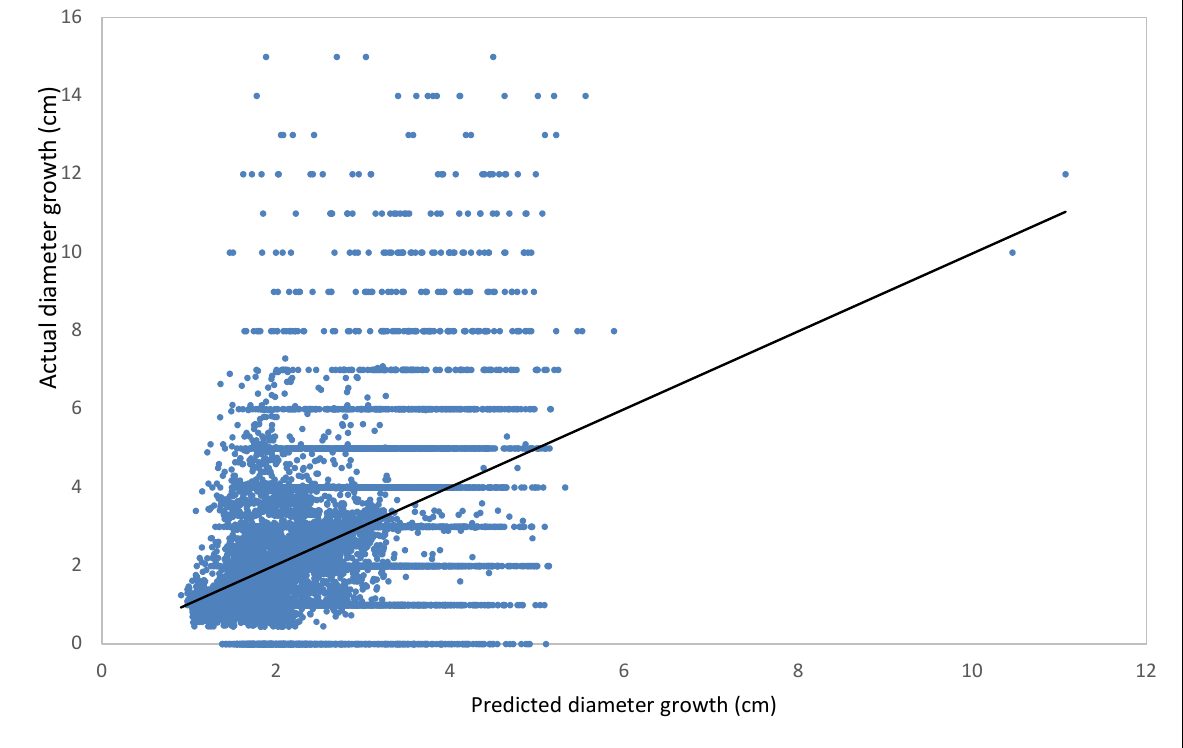
Figure 11. Relationship between predicted and actual diameter increment for future time by ANN (cm) affected by climate change. The influential factors in this method are DBH, basal area, basal area large, aspect, temperature, elevation, ratio basal area large to basal area, precipitation, ratio basal area to basal area large, and slope (Figure 12).